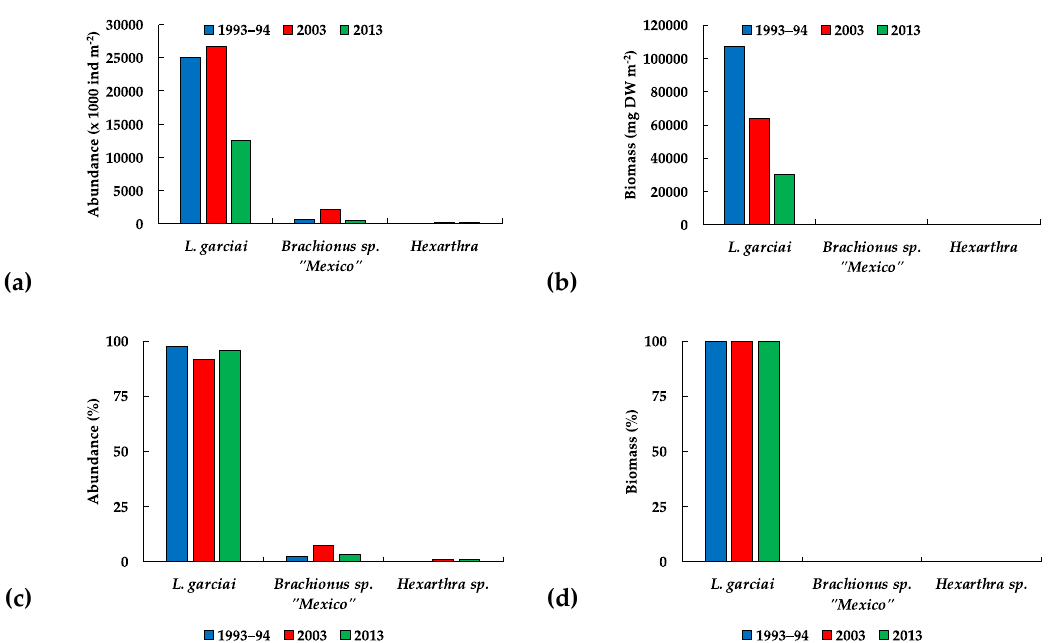
Figure 12. Per species contribution to the ( a ) absolute and ( c ) relative abundance, and ( b ) absolute and ( d ) relative biomass of the three zooplankton species in Lake Alchichica in the 3 annual cycles. (DW: dry weight).